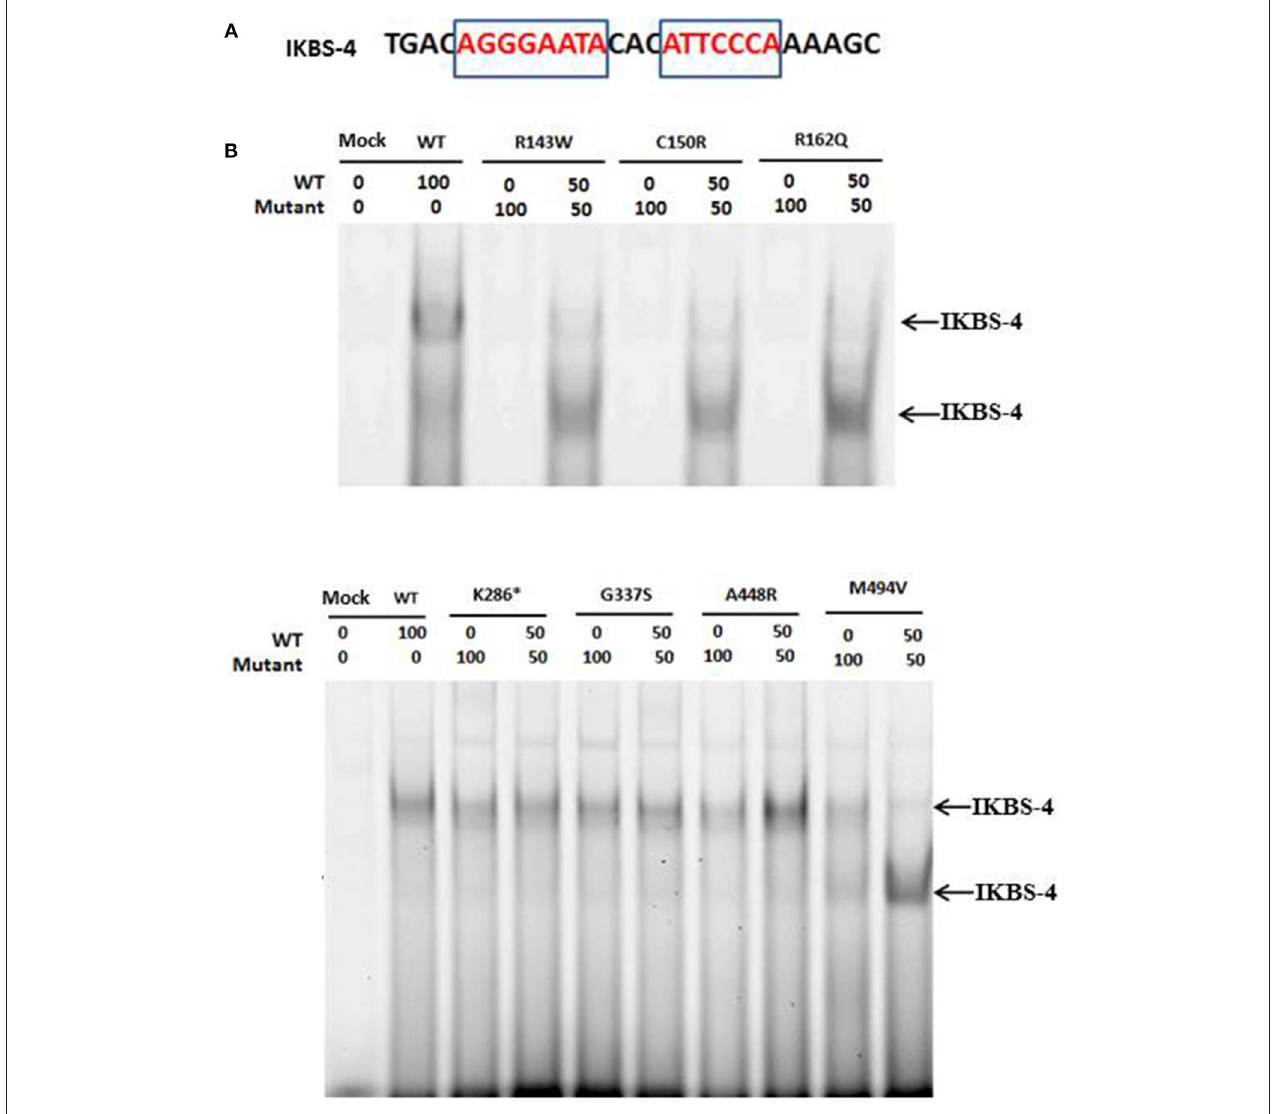
FIGURE 2 | (A) The sequence, used for the EMSA experiments is shown. Motifs that resemble the IKAROS consensus are shown in red in the rectangle. (B) Mutations affecting the DNA binding domain of IKAROS, preventing its binding to its target sequence. A specific gel-shift band, indicating binding of IKAROS multimers to the IKBS-4 DNA probe, was observed in the nuclear extract of HEK293T cells expressing the wildtype IKAROS. This band was absent in cells expressing the IKAROS variants Arg143Trp, Cys150Arg, and Arg162Gln and was weaker in the nuclear extracts of cells co-transfected with equal amounts of wildtype and one of the three mutant forms. A smaller band was also detected in the co-transfected samples, compared to the wildtype ones which can indicate the DNA-bound dimers of IKAROS. The DNA binding activity remained unaffected when the mutant variants Lys286*, Gly337Ser, Ala448Arg, and Met494Val were expressed.